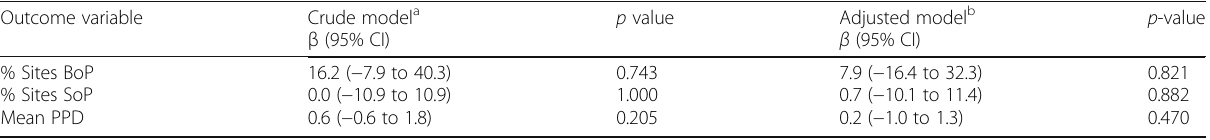
Table 5 Average differences in BoP, SoP, and PPD between the control and test group at 3-month follow-up Outcome